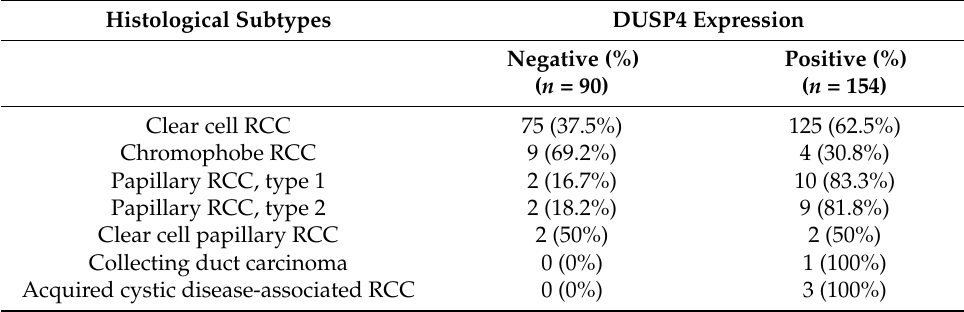
Figure 2. The ratio of DUSP4 positive to DUSP4 negative cases in RCC according to histological subtypes. Table 2. Differences in DUSP4 expression by histological subtype.